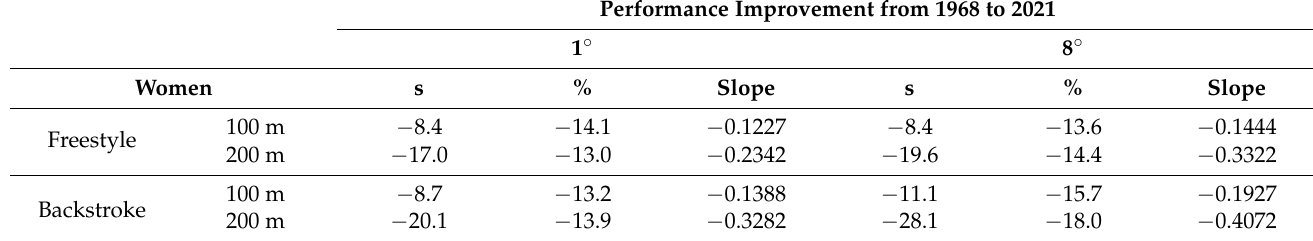
Table 6. Performance improvement in second (s), percentage (%) and slope of the regression line of results over time (slope) from 1968 to 2021 in Freestyle and Backstroke 100 m and 200 m for the women gold medallist (1 ◦ ) and last finalist (8 ◦